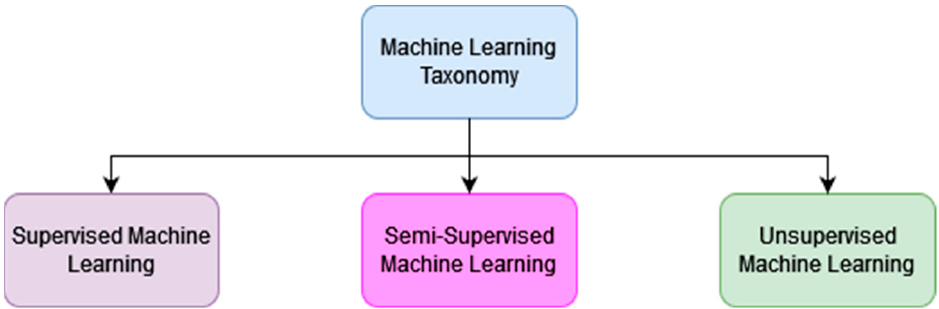
Figure 2. Main types of machine learning